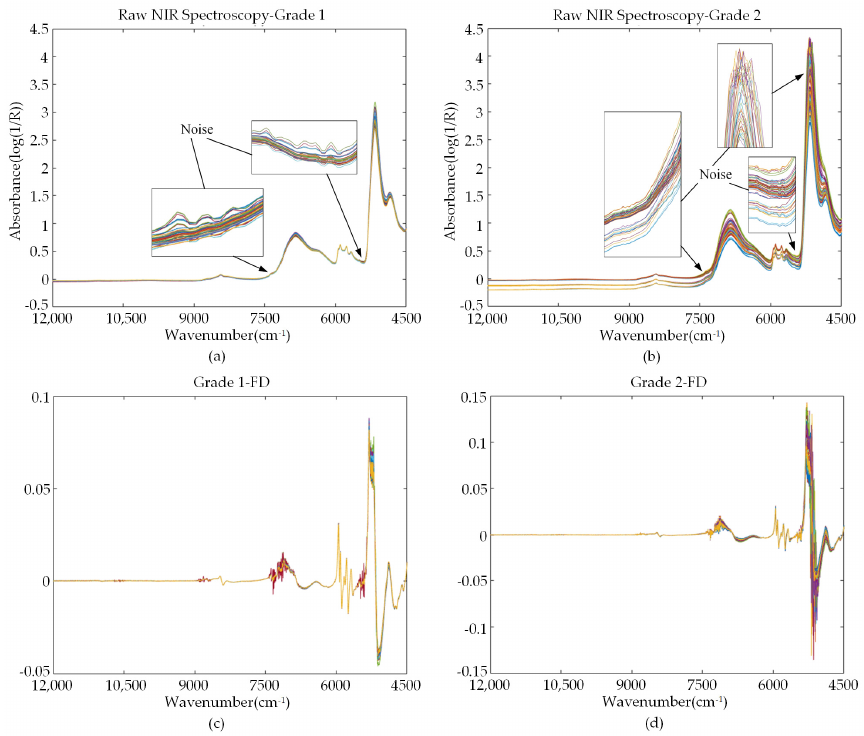
Figure 3. ( a , b ) Raw NIR spectra of sample sets I and II; ( c , d ) first derivative preprocessed NIR spectra of sample sets I and II.